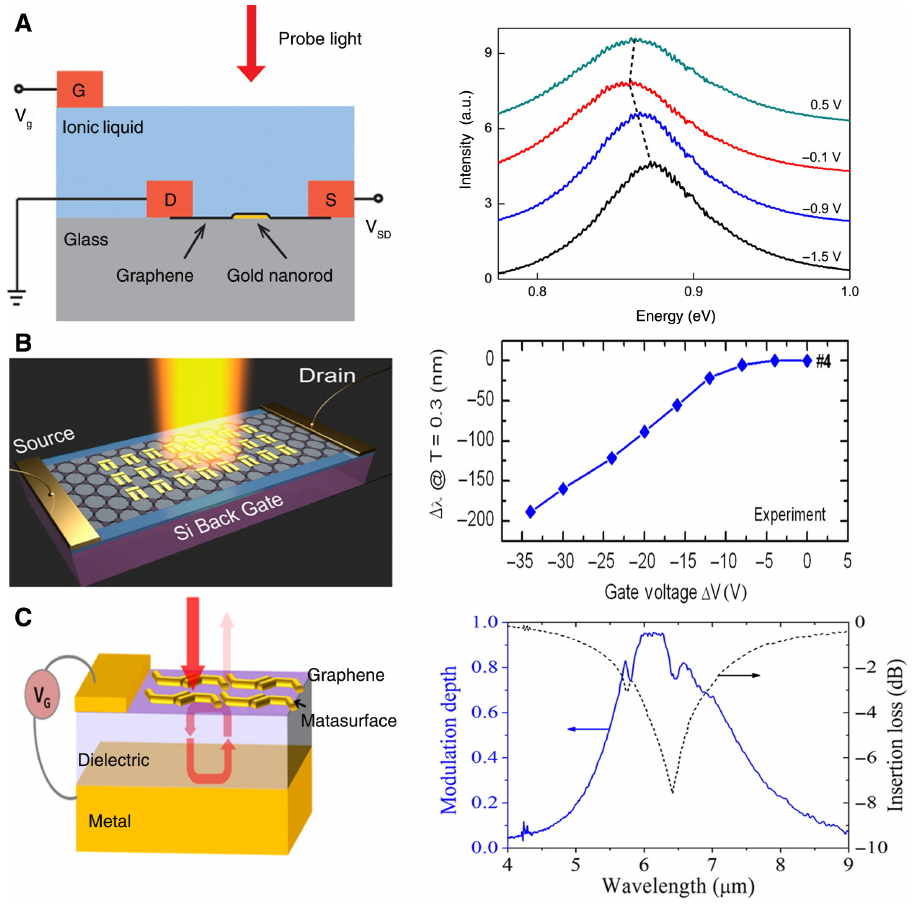
Figure 6: Plasmonically enhanced electro-optic modulation under normal illumination. (A) The hybrid graphene–Au nanorod system exhibits a 20-meV shift of resonance frequency and a 30% increase in quality factor upon external voltage. (B) Metallic bowties are employed to enhanced light–matter interaction within the channel region of FET, resulting in an effective modulation with a resonance wavelength decrease of 210 nm. (C) Metallic nanostructures are placed on top of the graphene, which combine with the metal reflector on the bottom of the dielectric interlayer. The designed structure forms a perfect absorber, exhibiting a modulation depth up to 100%. Reproduced/adapted with permission from Kim et al. [185] (A), Emani et al. [187] (B), and Yao et al. [188]